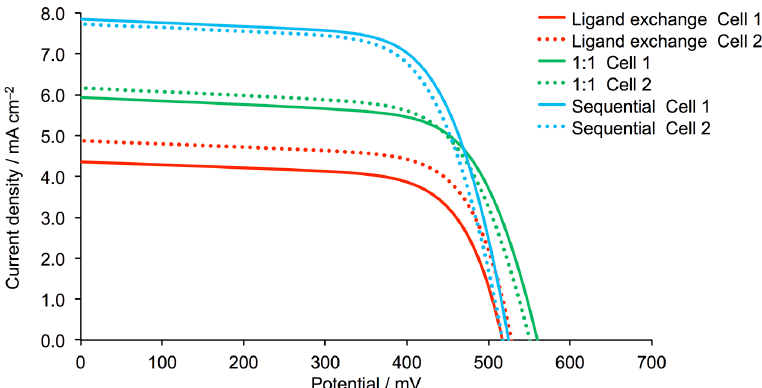
Figure 7. J–V curves for duplicate DSSCs with photoanodes assembled using the three dipping methods (ligand exchange, 1:1 mixture and sequential) described in the Materials and Methods section.